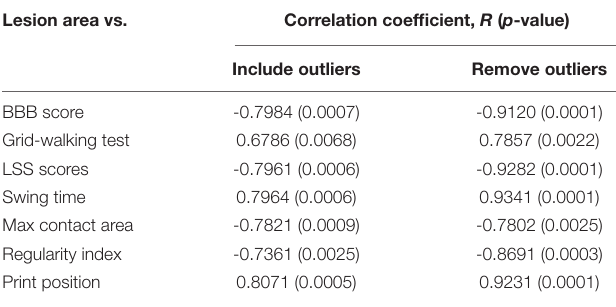
TABLE 1 | Relationships between lesion area and behavior testing. Lesion area